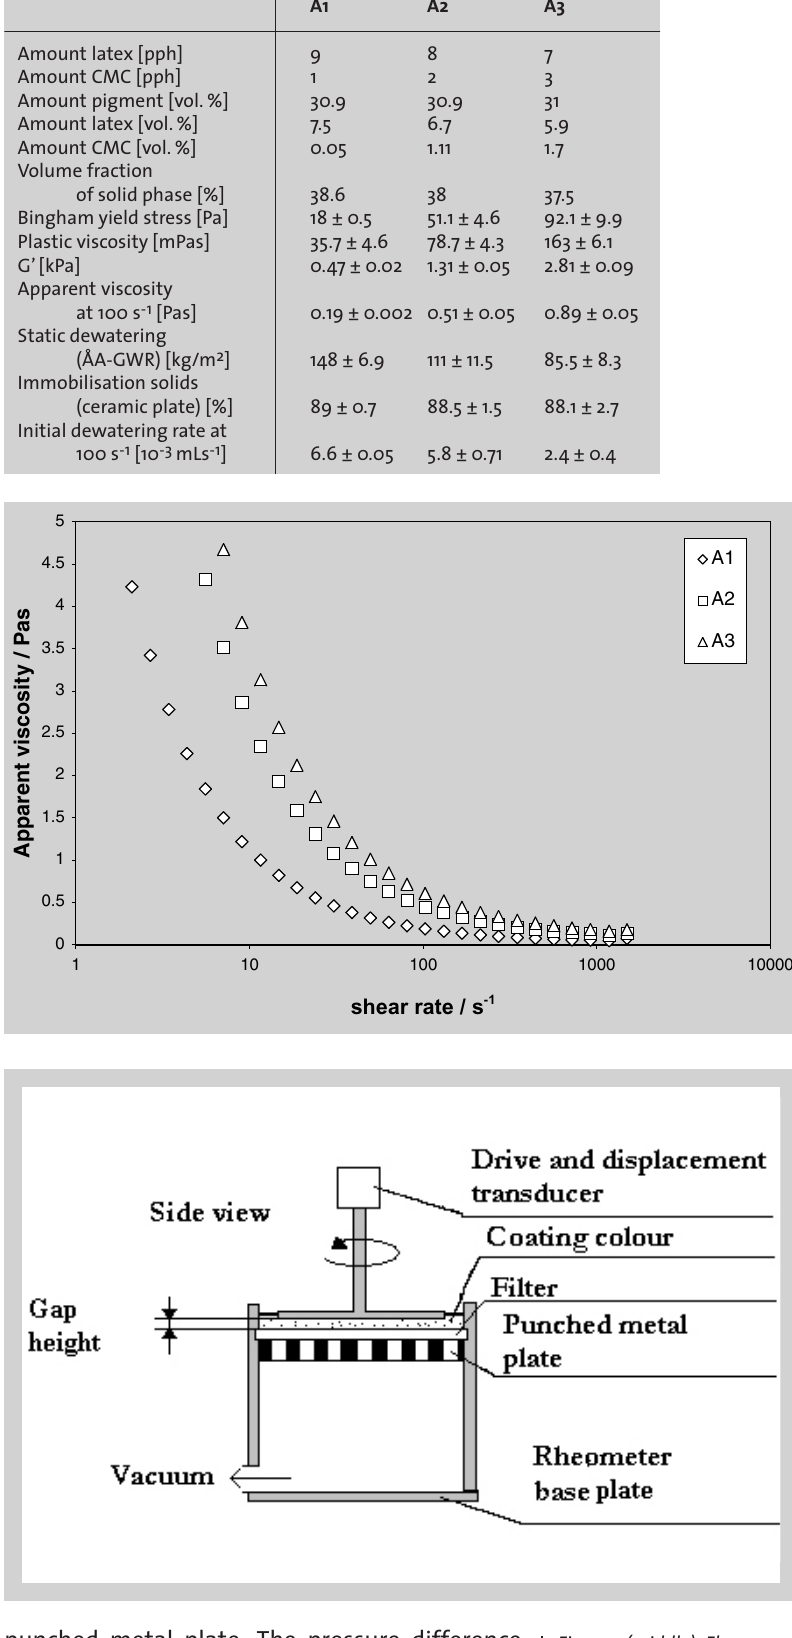
Figure 1 (middle): Flow curves for all three coating colours at 25˚C and pH = 8.5. Figure 2 (below):